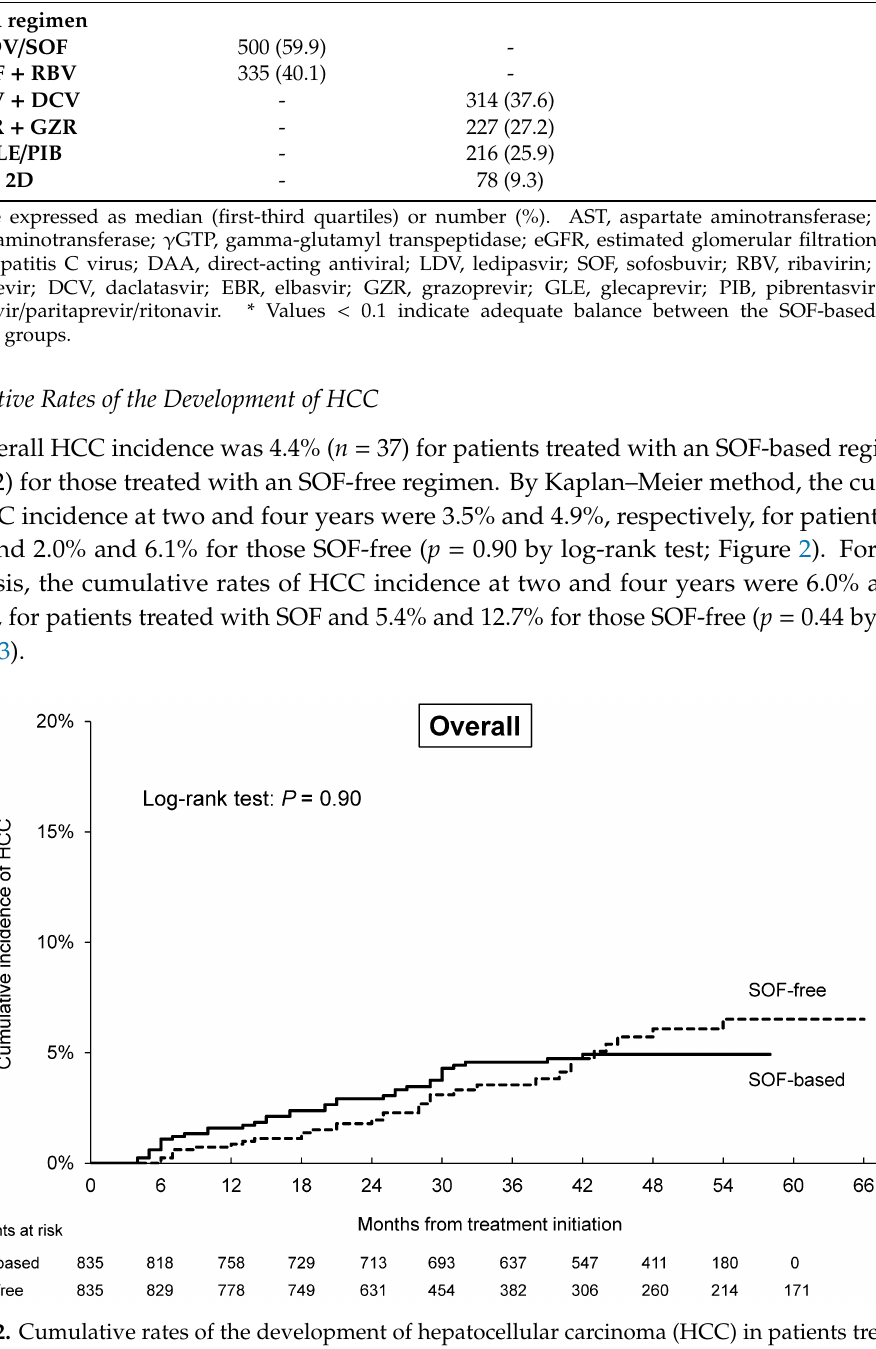
Figure 3. Cumulative rates of the development of hepatocellular carcinoma (HCC) in cirrhotic patients treated with DAA regimens with and without sofosbuvir (SOF). SOF-based: continuous line, SOF-free: dashed line. 2.3. Incidence Rates for the Development of HCC within the First Two Years There were 38 cases of HCC during 3074.2 person-years (PY) of follow-up within the first two years after treatment initiation. In our analysis of the incidence of HCC according to the regimen